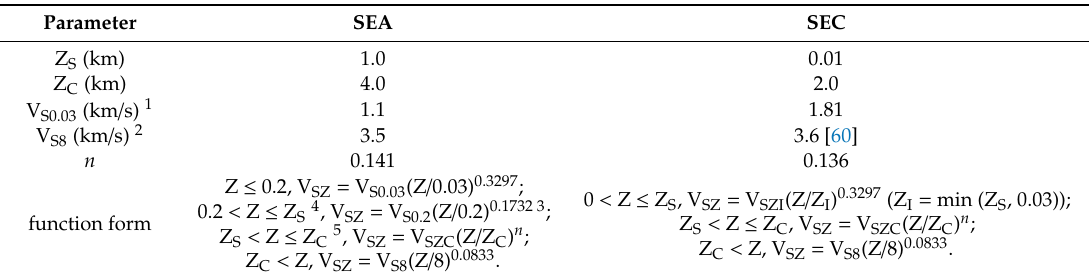
Table 3. Parameter values for modelling shear wave velocity (SWV) profiles for South-Eastern Australia (SEA) and South-Eastern China